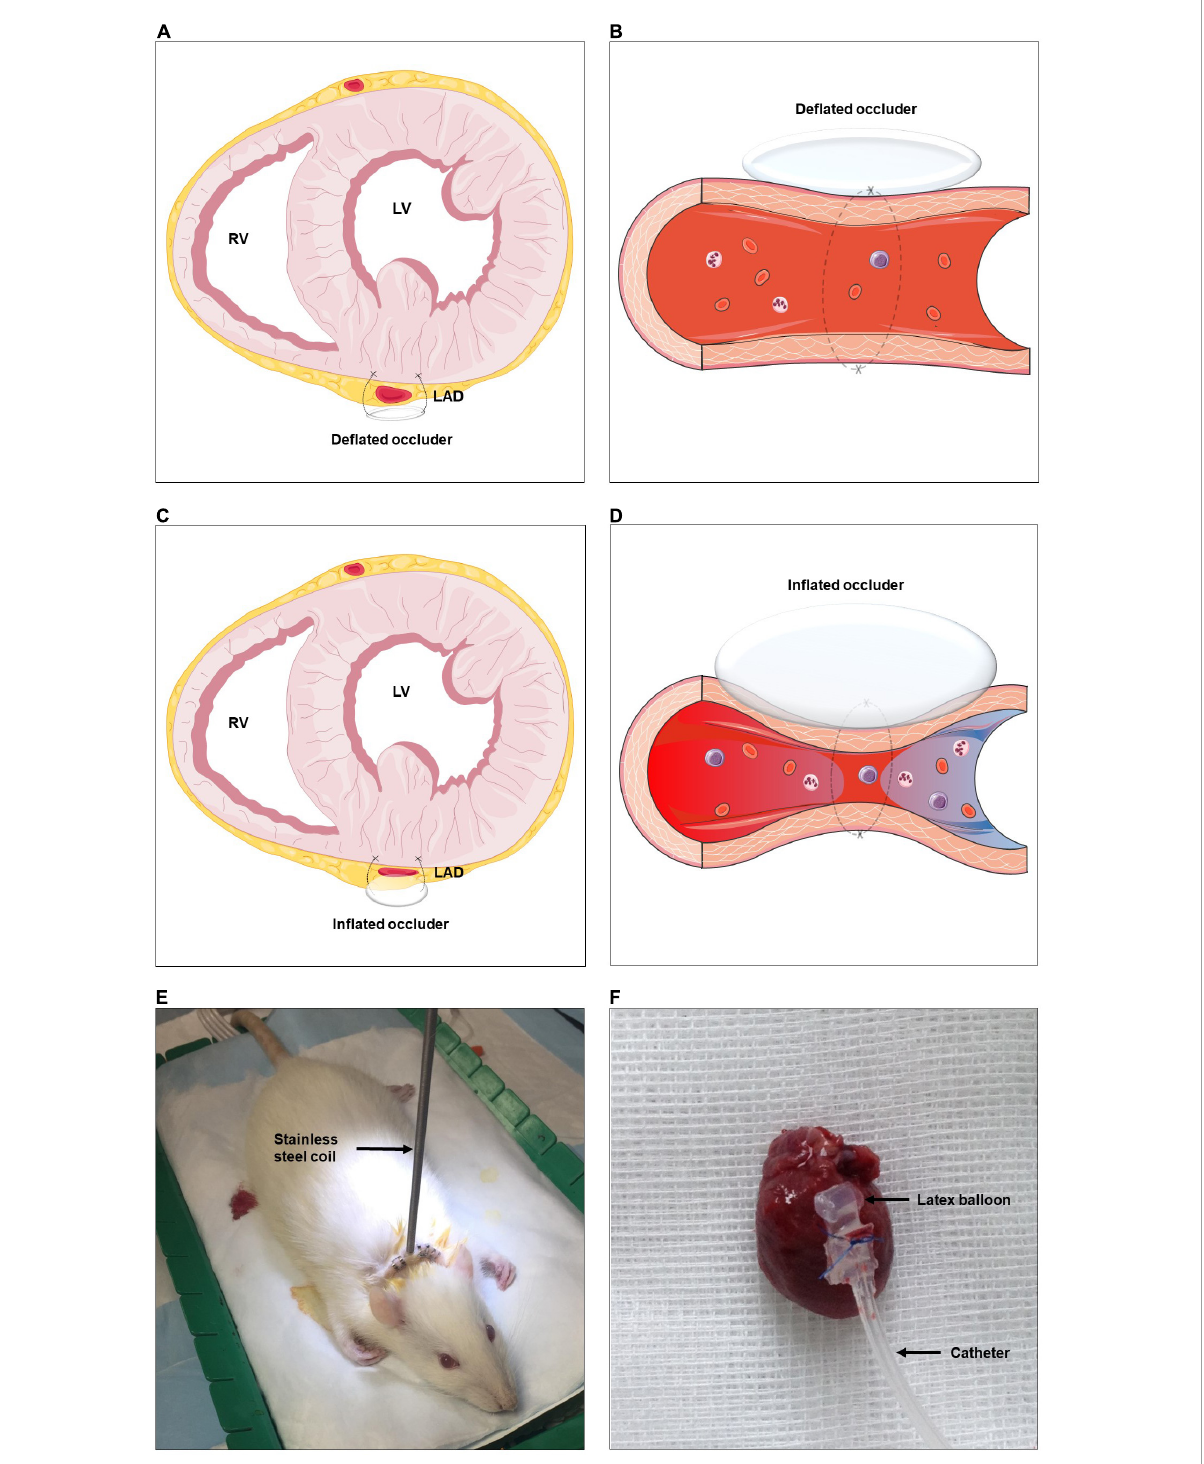
FIGURE2 Schematic representation of rat model of coronary arteriogenesis. RV, right ventricle; LV, left ventricle; LAD, left anterior descending artery. (A–D) A highly flexible latex balloon catheter is fixed around the proximal LAD, compressed air is used to briefly and temporarily inflate the catheter, repetitively ligating the LAD, and thus stimulating coronary collateral development. (E) Established rat model with the stainless steel coil. (F) Sample of excised rat heart with the occluder. The figures were partly generated using Servier Medical Art, provided by Servier, licensed under a Creative Commons Attribution 3.0 unported